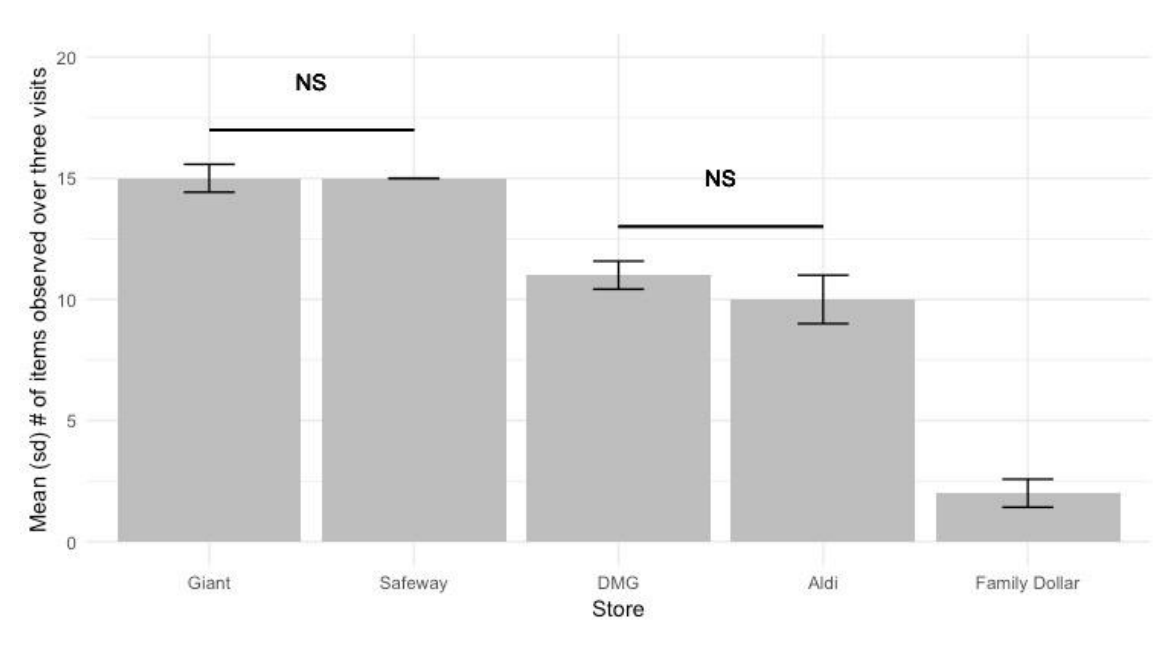
Figure 3. Average Number of Items per Store, Measured by Three Consecutive Observations with Three- Week